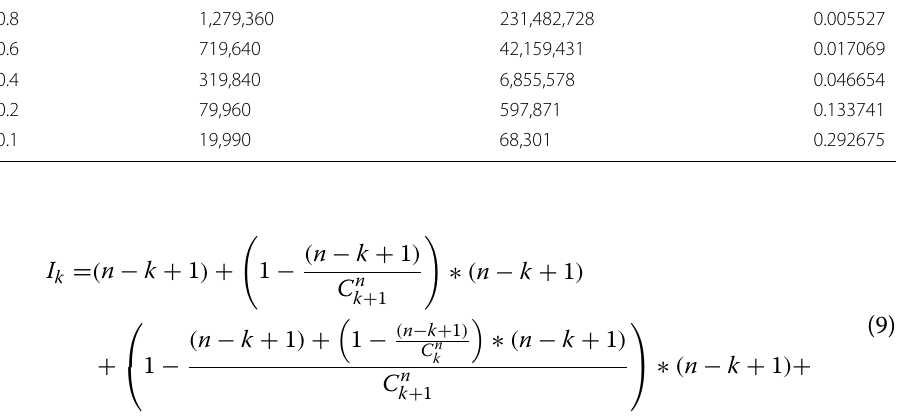
Table 12 Estimation of the number of itemsets for larger datasets p #two